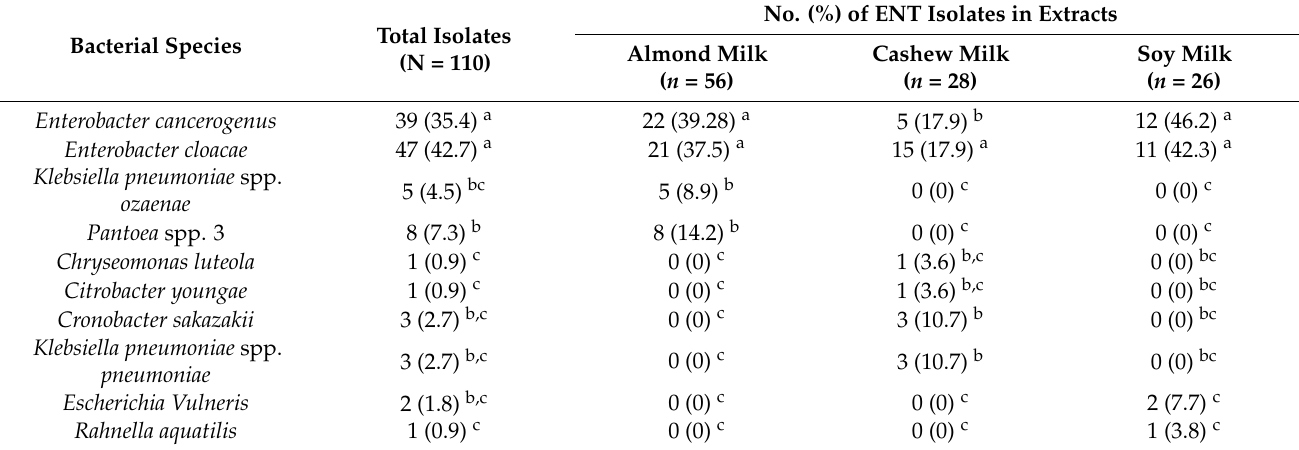
Table 1. Presence (%) of Enterobacteriaceae in Nut and Seed